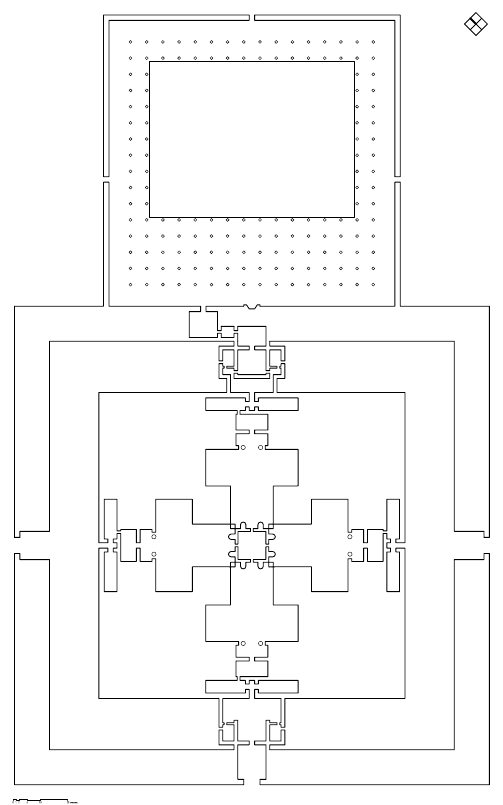
fig. 7. Hypothetical Plan of the Great Mosque and the Palace of Green Dome. Source : reproduced by the author after